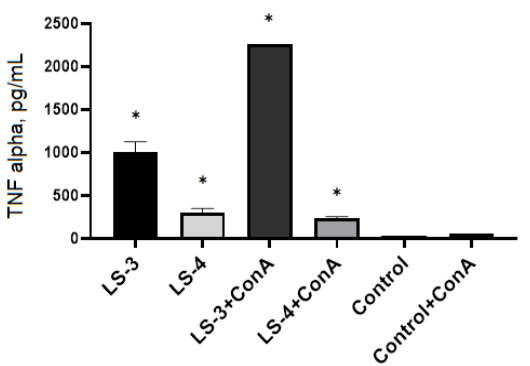
Figure 9. Effects S. sclarea L. extracts on the secretion of TNF- α by spleen T lymphocytes. (LS-3)—sage extract obtained by conventional extraction and (LS-4)—sage extract obtained by ultrasonic-assisted extraction. Two controls were used in the experiment: spleen T lymphocytes without treatment or stimulus and spleen T lymphocytes activated with Con A. (*) indicates significant differences in comparison to control, p < 0.05.